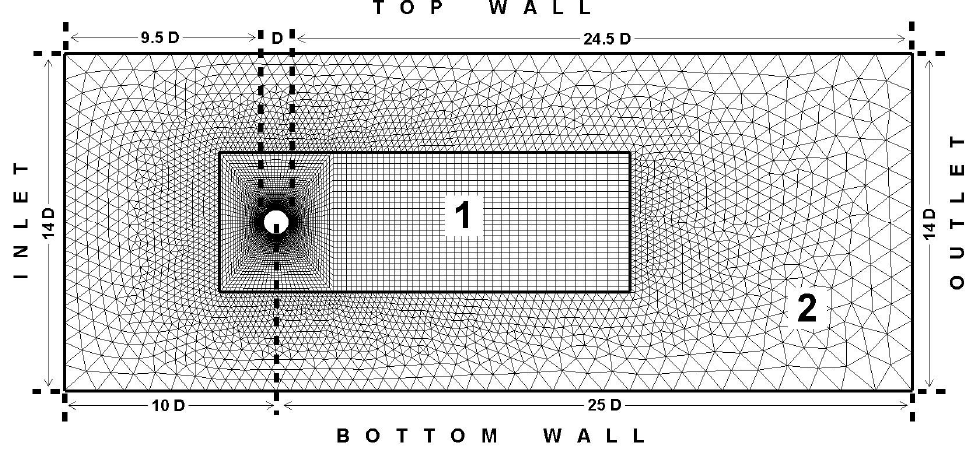
Figure 7. Details of the computational domain and the boundary conditions. In this figure, region 1 is the moving domain while region 2 is the stationary domain. 𝑘 –𝜔 𝑆𝑆𝑇 was selected as the turbulence model to solve the turbulent flow around Table 2. A summary of boundary conditions and computational domain